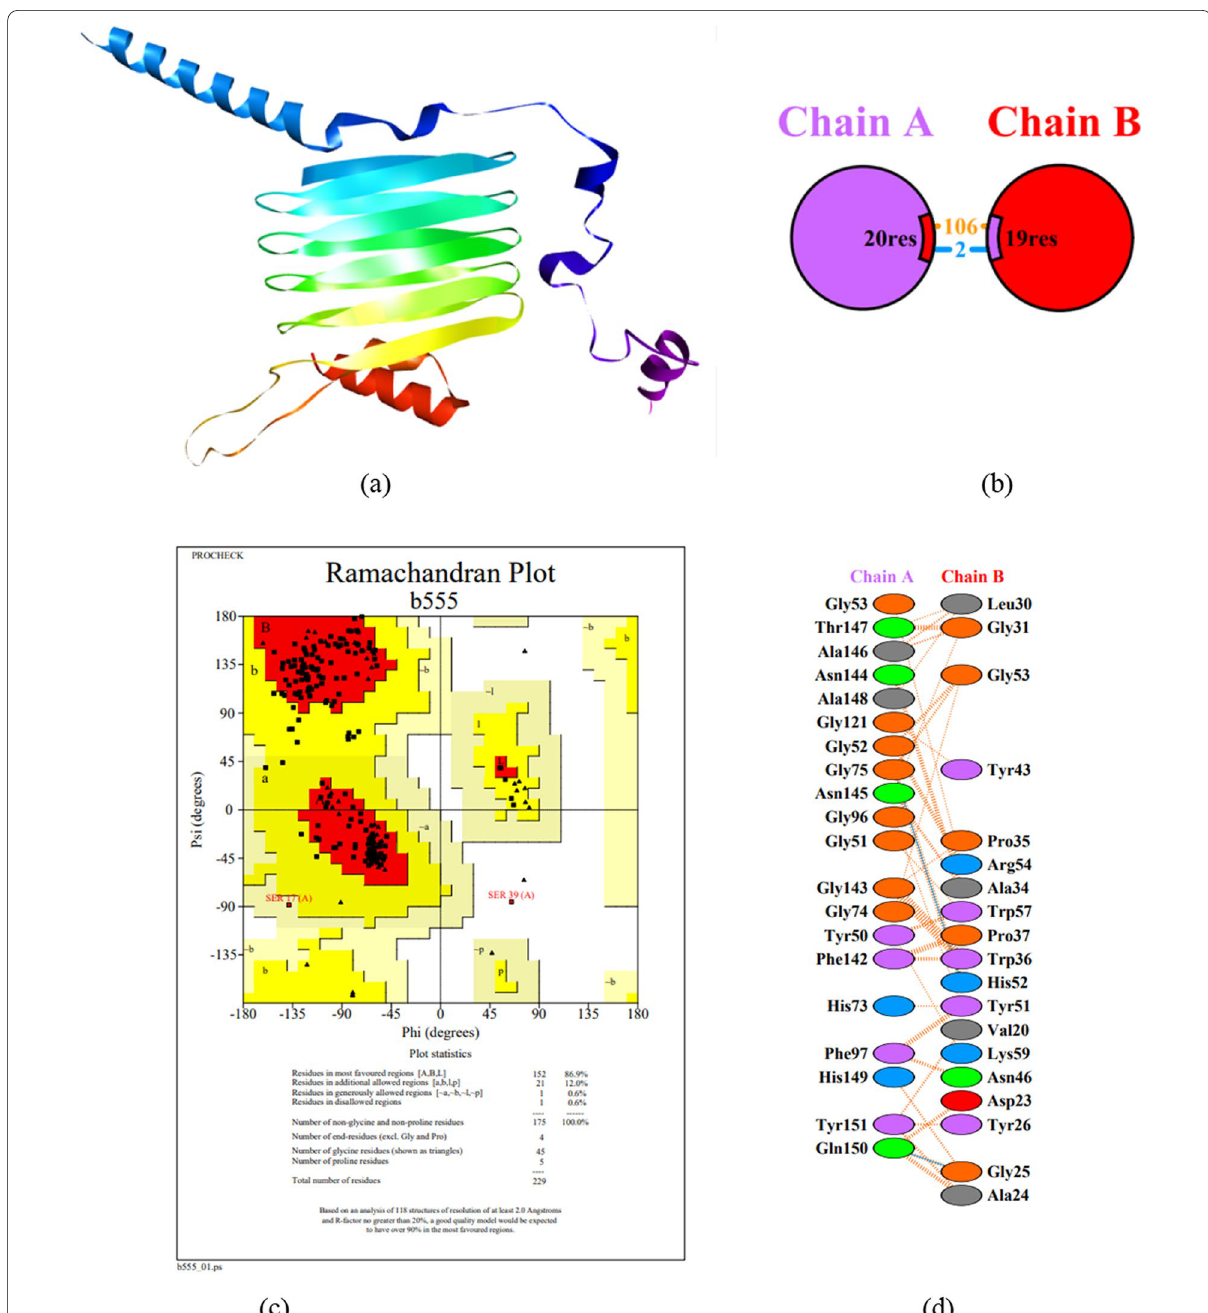
Fig. 4 a Structure of chimeric protein. b Binding of two CsgA-mfp3 proteins to each other obtained by molecular docking using a Cluspro server. b Evaluation of docking results using the PDBsum server. c Ramachandran plot diagram. d Residues involved in the interaction of the chimeric protein